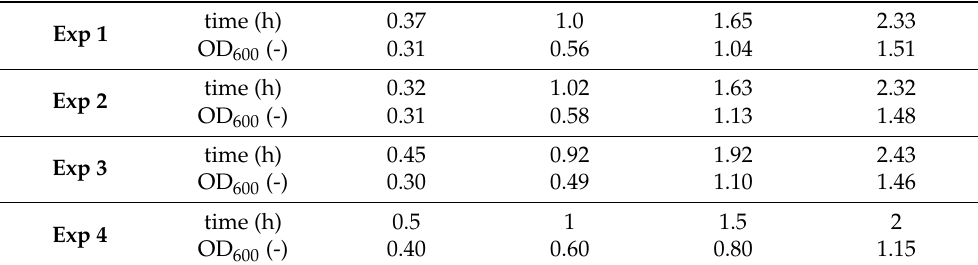
Table 1. Optical density at 600 nm (OD 600 ) measured over time for the bacterial culture during the exponential growth phase. Four independent experiments were done (Exp 1, Exp 2, Exp 3 and Exp 4